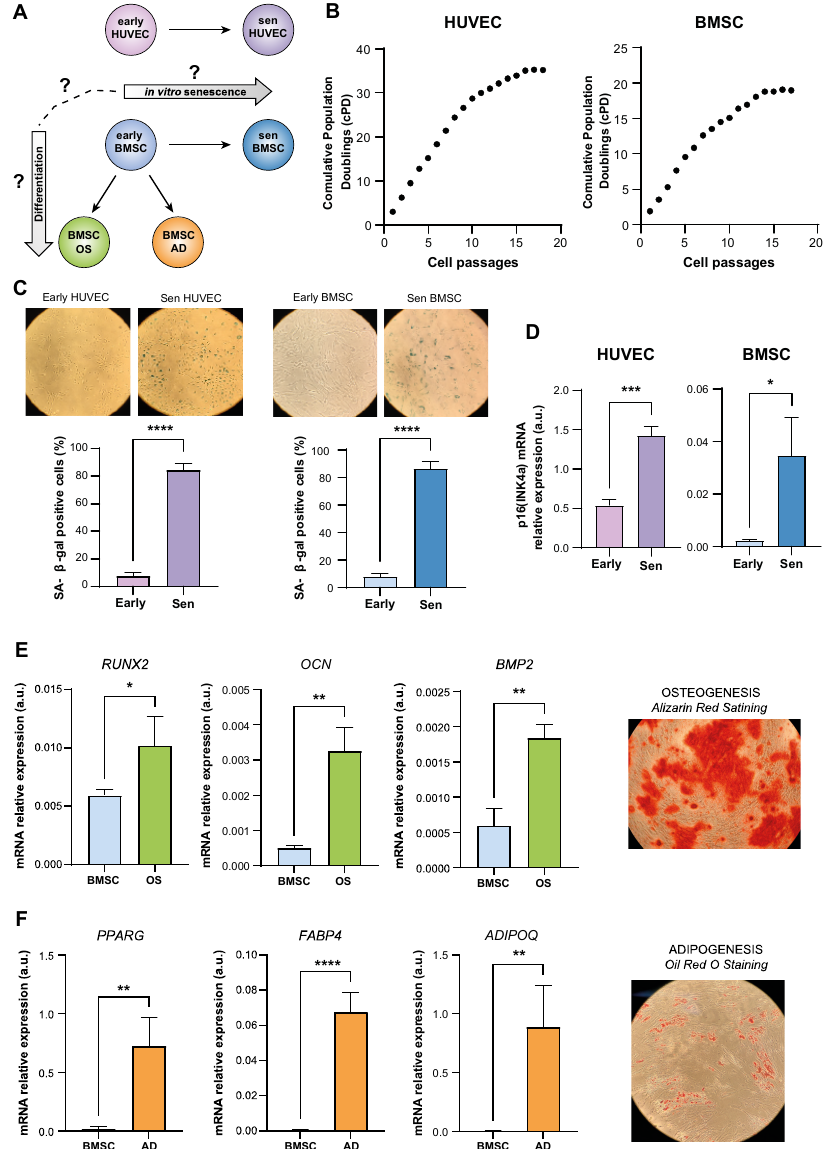
Figure 1. Experimental design and characterization of cellular models used for genome-wide DNAm analysis. ( A ) Experimental design: early-passage HUVECs and BMSCs were cultured until they reached replicative senescence (Sen); BMSCs were induced to differentiate into adipocytes (AD) and osteoblasts (OS) for 15 days. ( B ) Growth curve showing Cumulative Population Doublings (CPDs) of BMSCs and HUVECs. ( C ) Representative images and quantification of the SA β -Gal staining positivity in early (SA β -Gal < 10%) and senescent (SA β -Gal > 80%) HUVECs and BMSCs. ( D ) p16(INK4a) relative expression in arbitrary units (a.u.) in early and senescent cells obtained through Real Time PCR. Data were normalized using β -actin as internal control. ( E ) Runx2, Osteocalcin (OCN), and Bone morphogenetic protein 2 (BMP-2) relative expression (a.u.) and Alizarin red staining were used to verify the osteogenic differentiation (OS). ( F ) PPAR γ , Adiponectin (ADIPOQ) and Fatty Acid Binding Protein 4 (FABP4) mRNA relative expression and Oil Red O staining were used to verify the adipogenic differentiation (AD). Data were normalized using β -actin as internal control. Data are the mean ± S.D. of three independent experiments. *, p < 0.05; **, p < 0.01; ***, p < 0.001, ****, p < 0.0001 for paired t